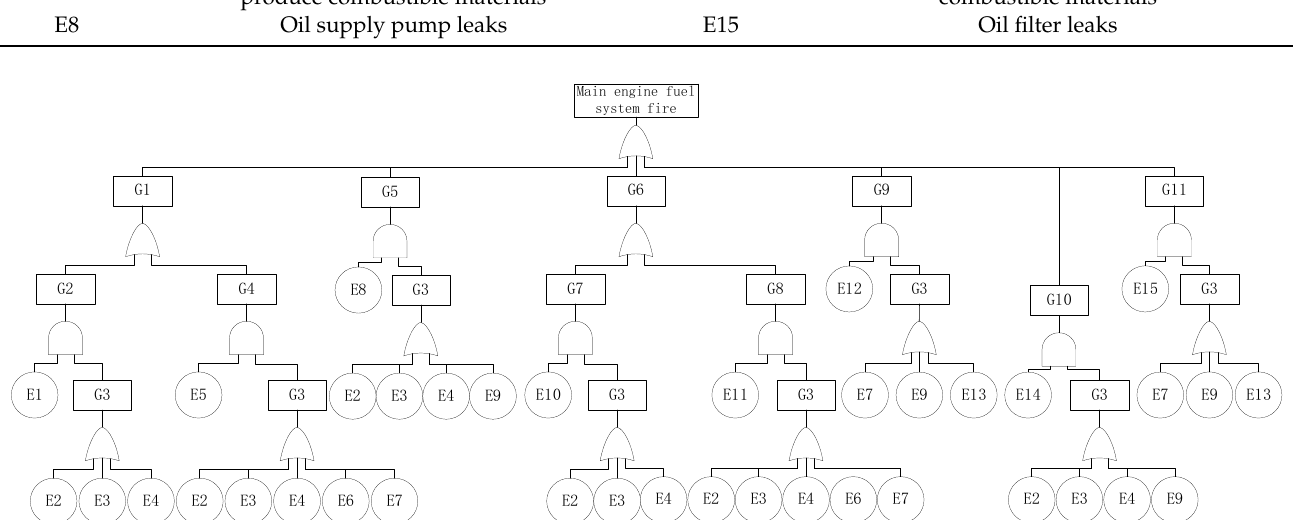
Figure 4. Fault tree of a main engine fuel system fire.